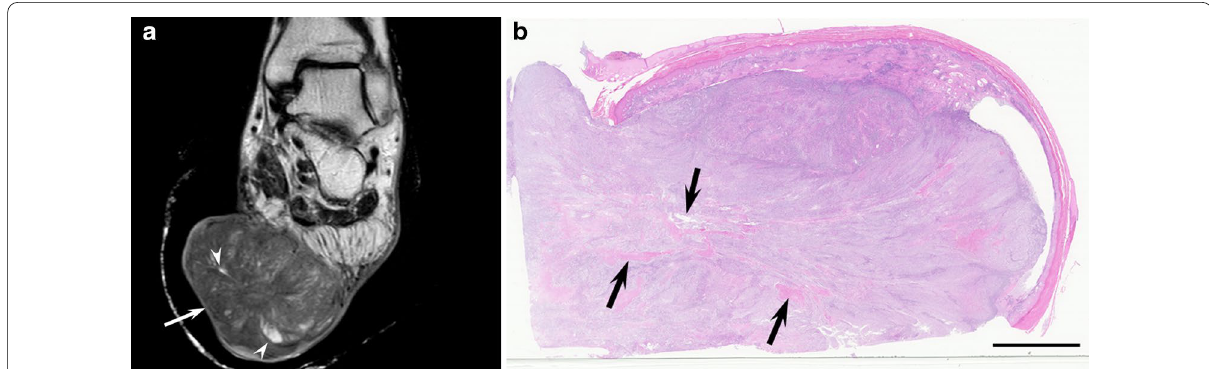
Fig. 6 A 66‑year‑old male with hidradenocarcinoma on the sole. a Sagittal T2‑weighted image showing an elevated huge mass (arrow) with (arrows)